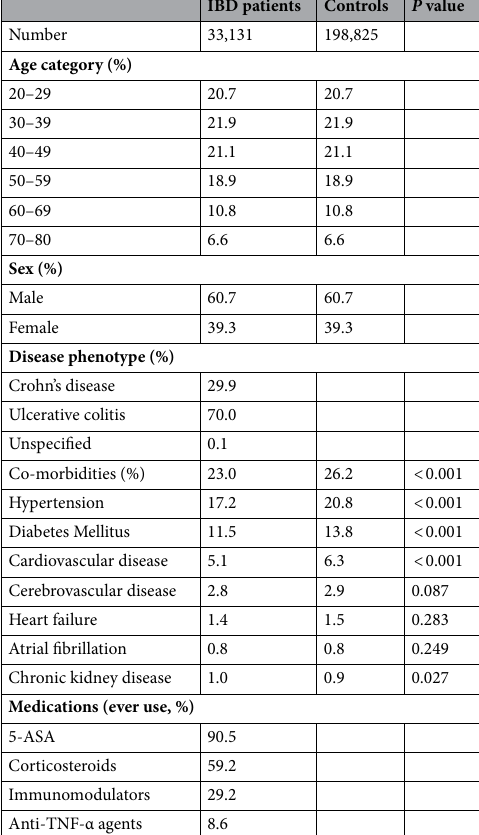
Table 1. Characteristics of study population, IBD patients versus controls. Values are expressed as means ± standard deviation or percentages. IBD inflammatory bowel disease; 5-ASA 5-aminosalicylic acid; Anti-TNF-α anti-tumor necrosis factor